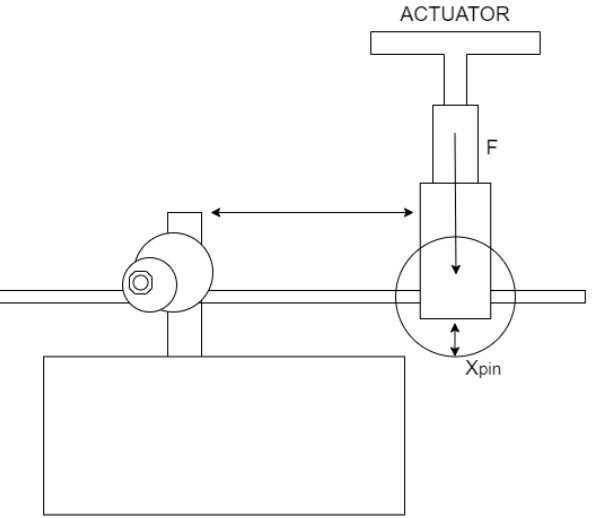
Figure 9. Simplified model for pin and clamp assembly behaviour under normal load, based on the results of both pin bending and interface